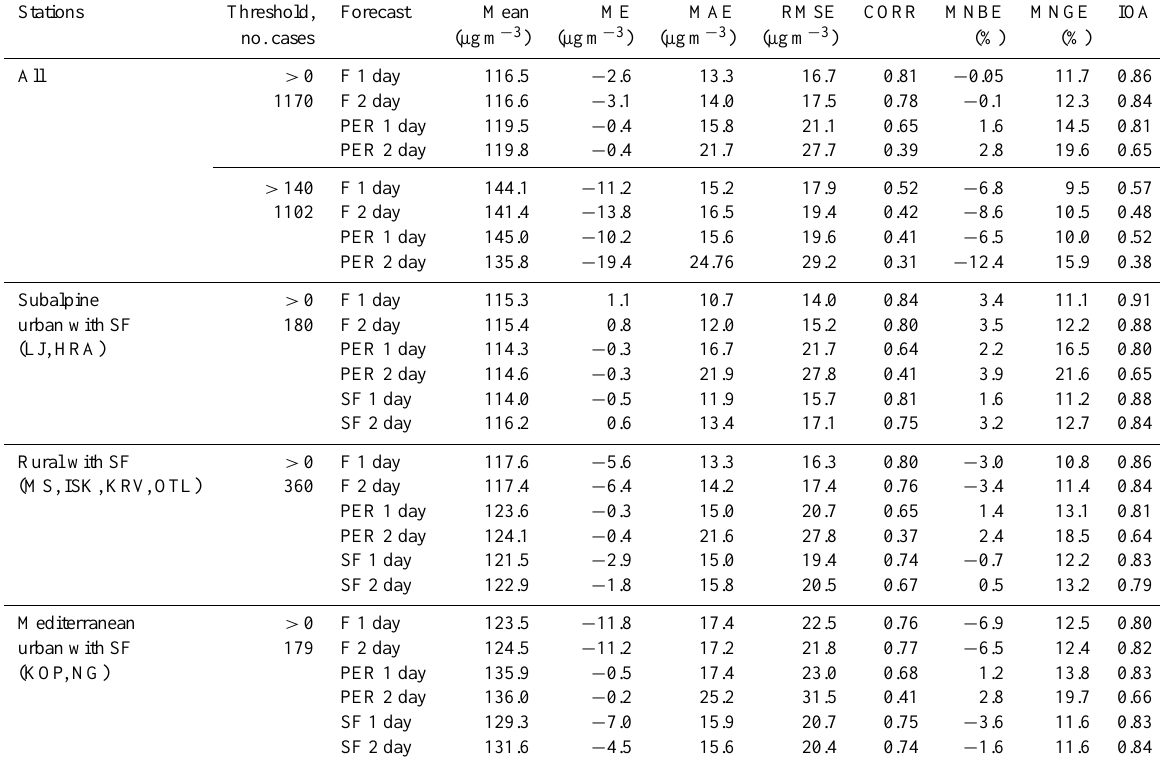
Table 4. Discrete evaluation of 1h daily maximum ozone predictions (PER: